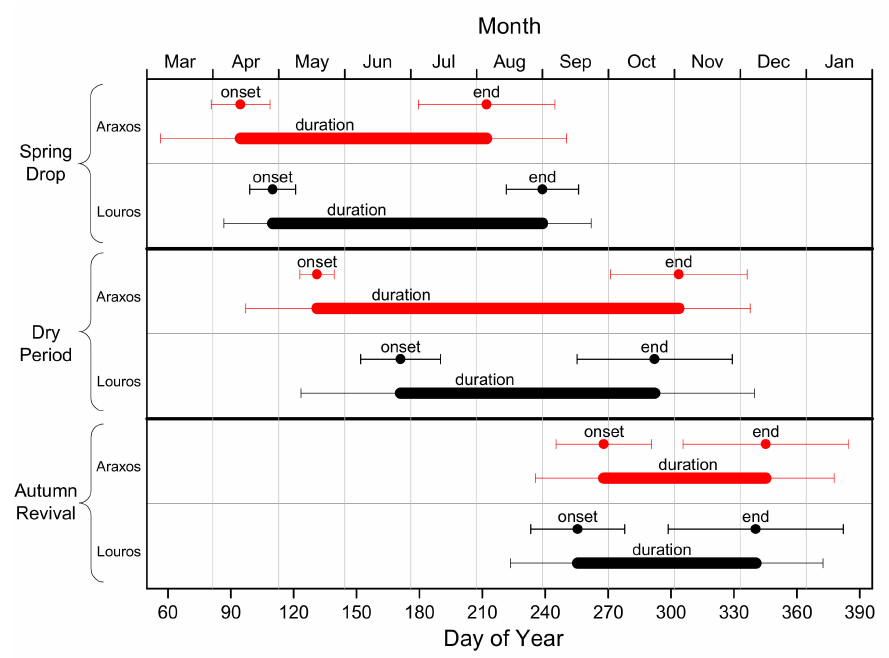
Figure 6. Graphical depiction of onset, duration, and end of the main phenological events (Spring Drop, Dry Period and Autumn Revival) for the two study sites. For all events, onset and end correspond to Day of the Year, whereas duration corresponds to number of days (data from Table